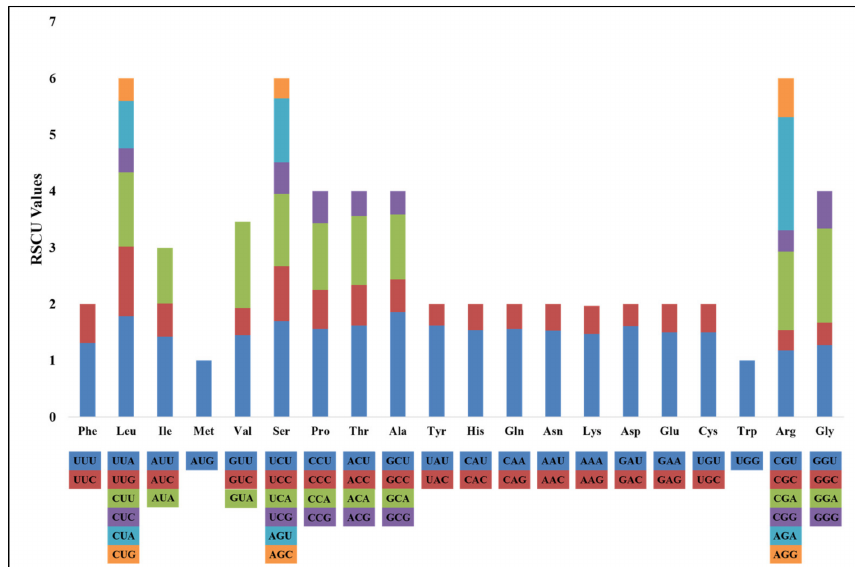
Figure 4. Codon composition for the 20 amino acids in the plastome of Ficus populifolia .